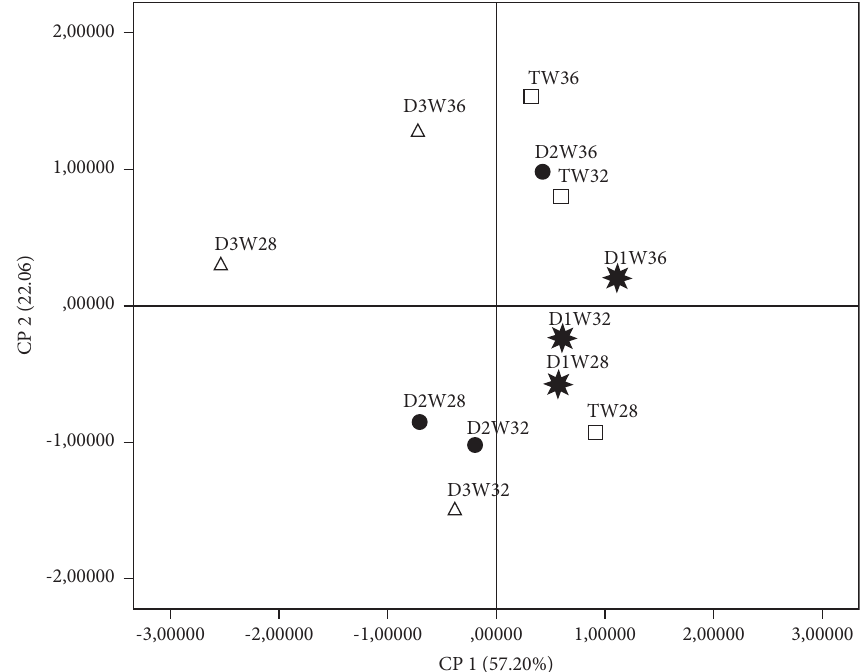
Figure 2: Projection of the variables of the four studied groups in the plane defned by two principal components. TW28: control week 28; TW32: control week 32; TW36: control week 36; D1W28: HS-10% week 28; D1W32: HS10% week 32; D1W36: HS-10% week 36; D2W28: HS-20% week 28; D2W32: HS-20% week 32; D2W36: HS-20% week 36; D3W28: HS-30% week 28; D3W32: HS-30% week 32; and D3W36: HS-30% week